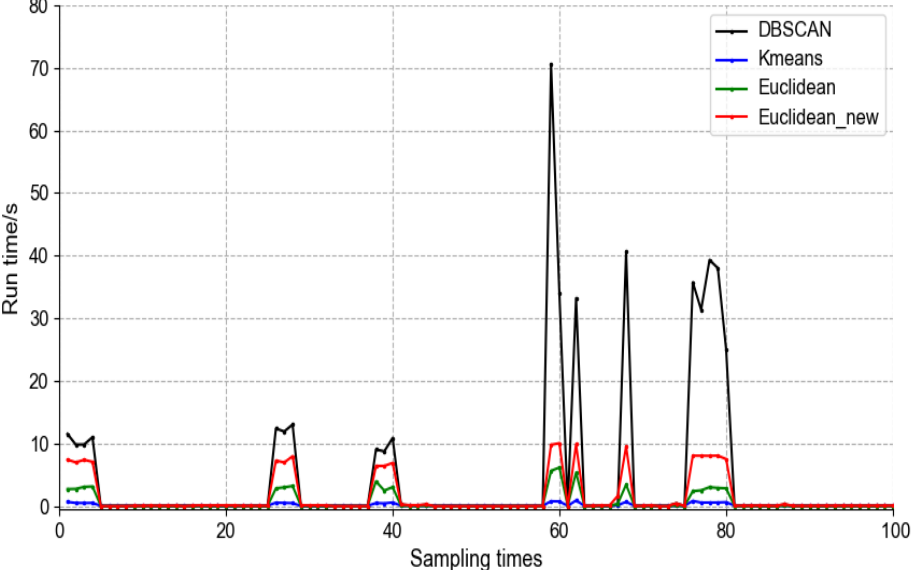
Figure 12. Analysis algorithm’s overall time-consumption.